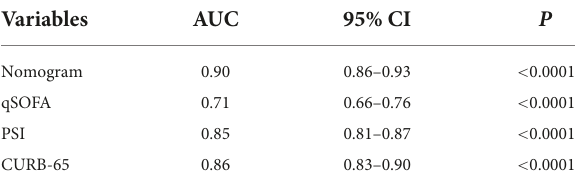
TABLE 4 The AUC of nomogram, PSI, CURB-65 and qSOFA for mortality in training